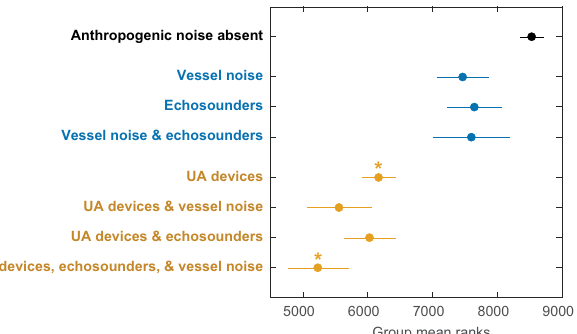
Fig. 4 Differences in hourly beaked whale acoustic detections. Following a Kruskal – Wallis test, pairwise comparisons were computed to assess whether Cuvier ’ s beaked whale acoustic presence on an hourly scale differed depending on the presence/absence of the various vessel-based anthropogenic sounds. The circles and lines represent the group mean estimates and comparison intervals, respectively. Groups sharing the same color are not statistically different from one another, although asterisks denote one signi fi cant pairwise comparison (* p < 0.05). See Supplementary Table 4 for all p values and sample